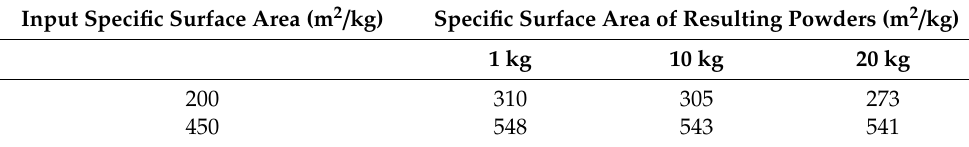
Table 2. Specific surface area of the cement powder at the beginning and after 10 and 20 kg.